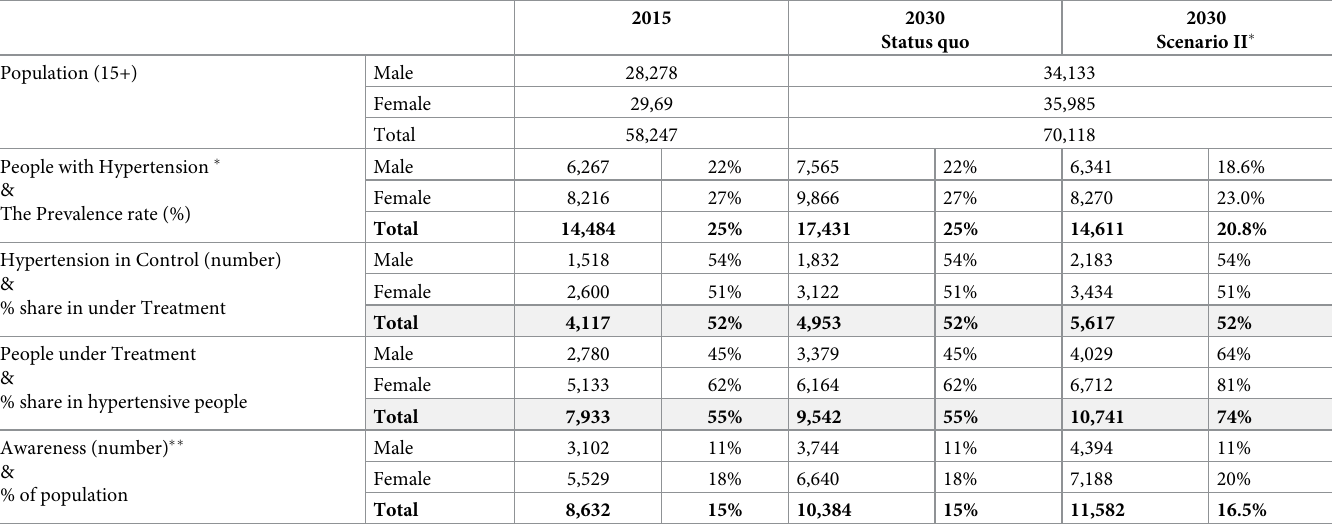
Table 4. Hypertensive population, prevalence, awareness, treatment, and control (000).